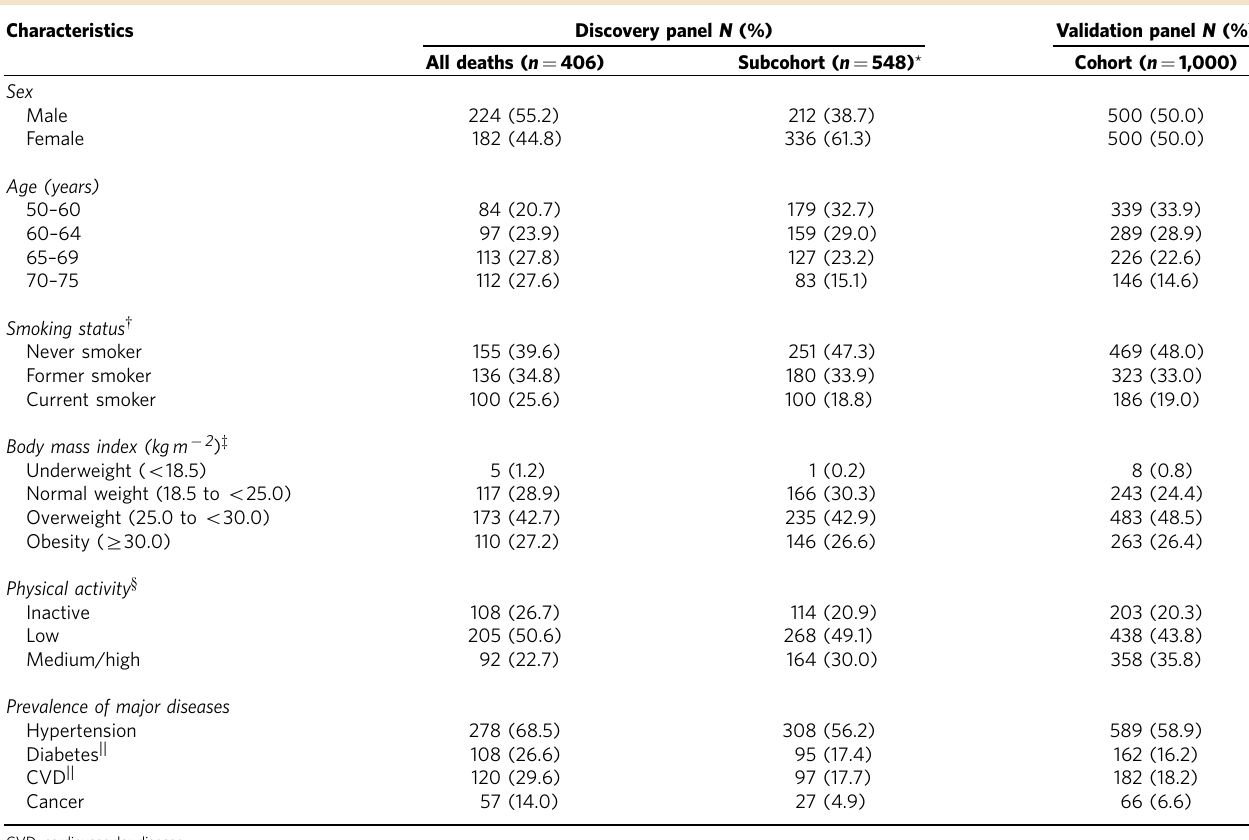
Table 1 | Characteristics of study population at baseline.